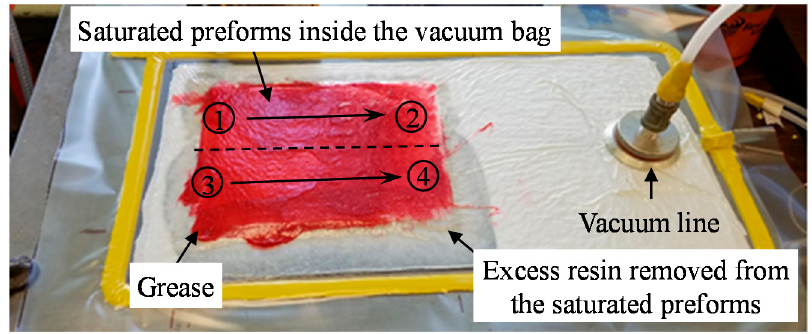
Figure 3. Wet layup/vacuum bag lay-up under vacuum. The magnet was applied to the greased (red) area. A single pass of magnet included compacting the lay-up from point 1 to 2 and point 3 to 4.